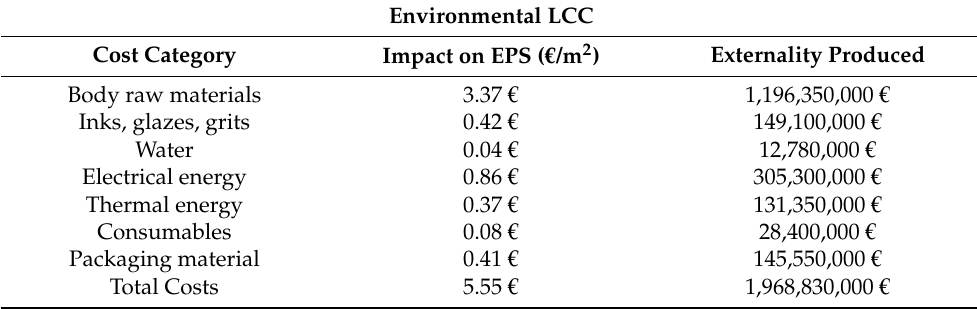
Table 3. Environmental LCC analysis (EPS method)—non-sustainable